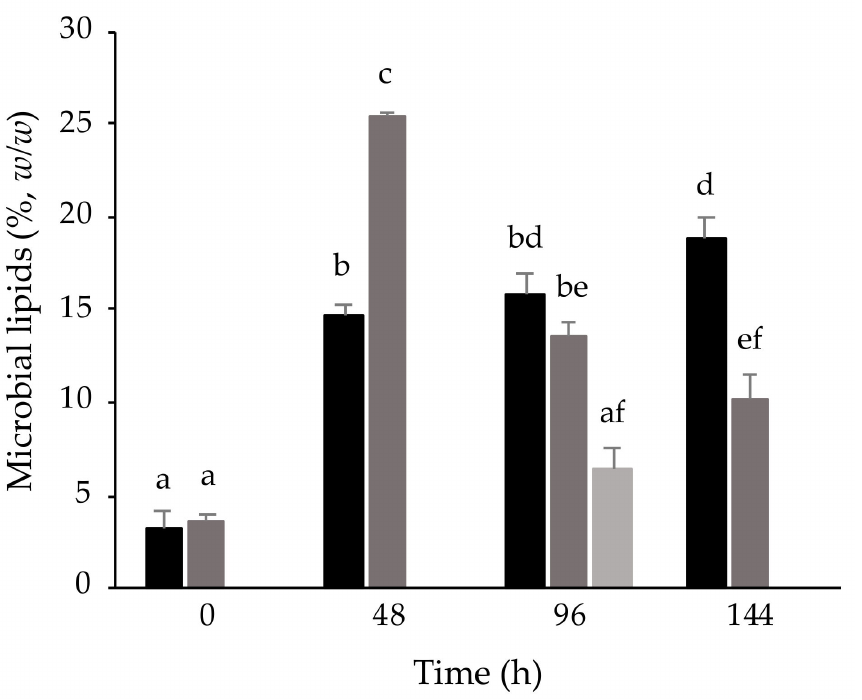
Figure 5. Microbial lipid content of C. tropicalis cells obtained in lab-scale bioreactor experiments carried out at pH 7 and 200 rpm (black bars), pH 7 and 500 rpm (dark gray bars), and pH 5.5 and 200 rpm (light gray bars). The error bars represent the standard deviation of two independent replicates. Bars with the same letter do not present statistically significant differences ( p ≤ 0.05). Table 7. Lipid concentration (LConc) and long chain fatty acids composition of C. tropicalis ATCC 750 cells obtained in a lab-scale bioreactor at pH 5.5 and 200 rpm, pH 7 and 200 rpm, and pH 7 and 500 rpm. Data are the average ± standard deviation of two independent replicates. Values followed by the same letter in each column do not present statistically significant differences ( p ≤